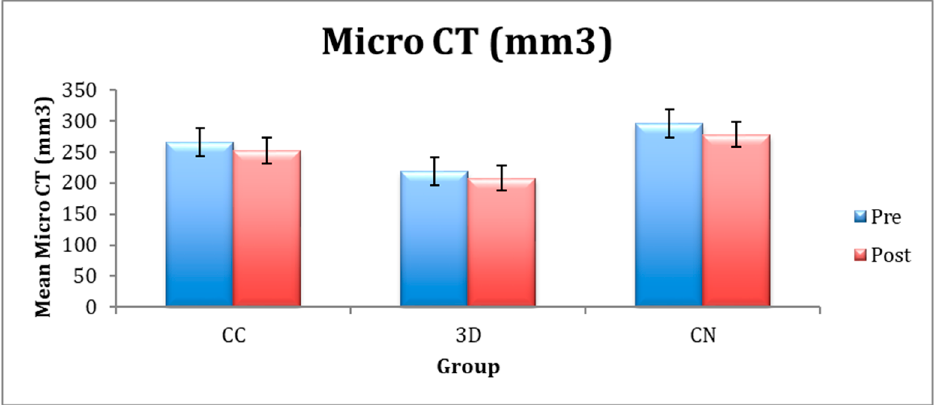
Figure 6. Comparison of surface wear among the study groups using micro CT. CC: CAD-CAM, CN: conventional, 3D: 3D printing, CL: cyclic loading.